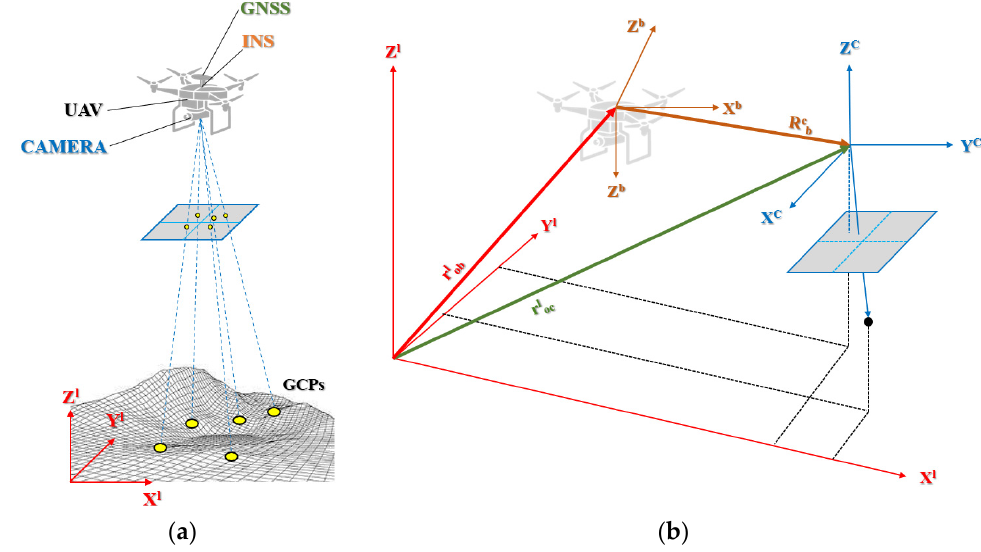
Figure 6. DG: acquisition scheme ( a ) and representation of several frames ( b ).